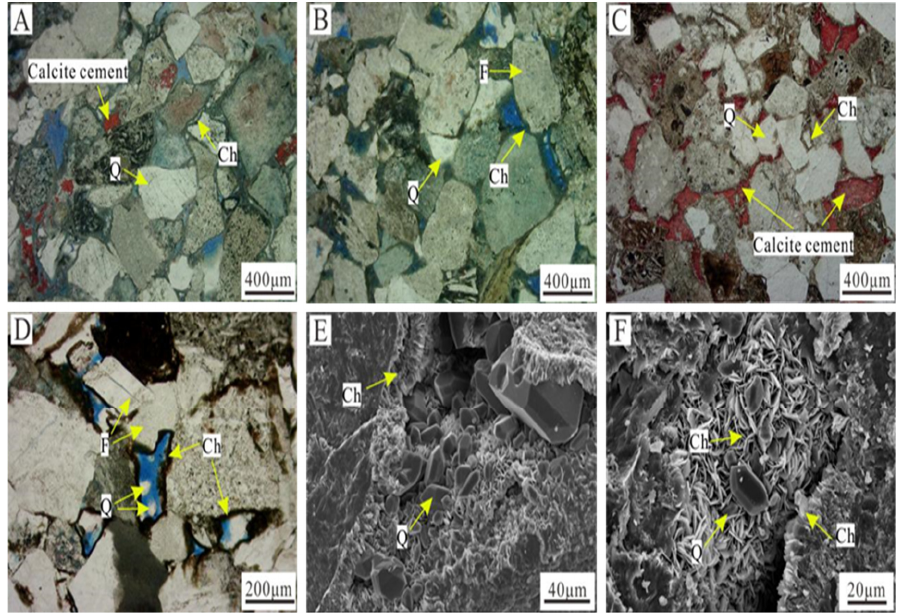
Figure 4. Relationship between authigenic chlorite and other diagenetic phenomena in Longfengshan subsag. ( A ) Pore-lining chlorite is developed, weak carbonate cementation, well Bei 202, 2994 m, plane-polarized light. ( B ) Pore-lining chlorite is developed, no carbonate cementation, well Bei 202, 3098.9 m, plane-polarized light. ( C ) Pore-lining chlorite and carbonate cementation develops, carbonate cementation is later than pore-lining chlorite, well Bei 206, 3363.77 m, plane-polarized light. ( D ) The intergranular pores surrounded by pore-lining chlorite are filled with authigenic quartz, well Bei 201, 3398.01 m, plane-polarized light. ( E ) The intergranular pores surrounded by pore-lining chlorite are filled with authigenic quartz, well Bei 202, 3075.43 m, SEM. ( F ) Pore-filling chlorite coating part of authigenic quartz, well Bei 202, 3113.53 m, SEM. Ch—Chlorite; Q—Quartz;